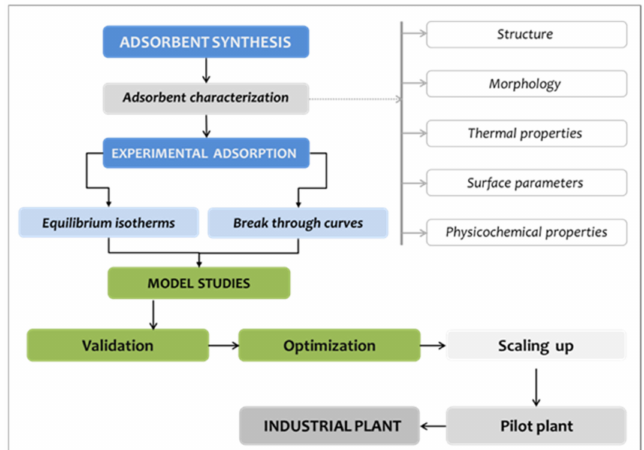
Figure 1. Stages in the development and testing of adsorbents for industrial